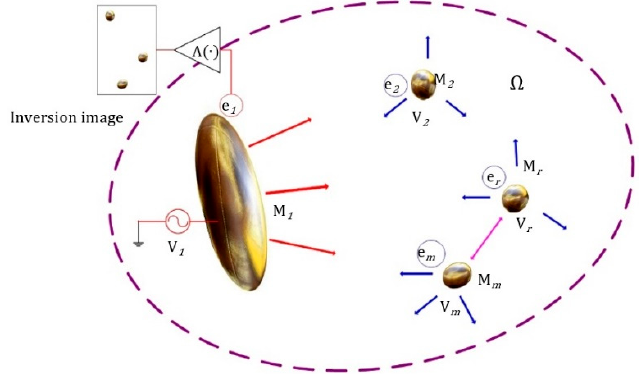
Figure 1. Mechanism of capacitance detection of multi-metal wear debris.